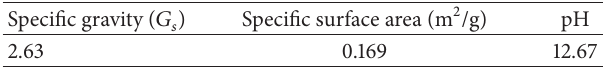
Table 3: Some physical properties of